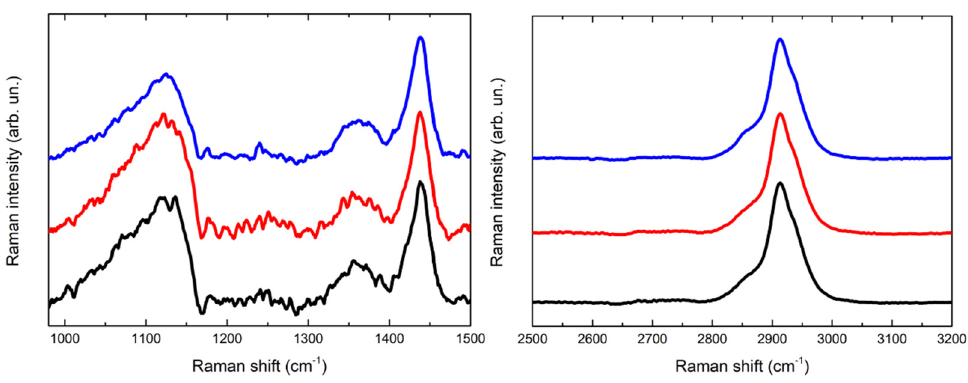
Figure 5. Comparison of three Raman spectra acquired for the reference of PVA-borax hydrogel. Table 1. Tentative assignations of observed Raman peaks for PVA-borax hydrogel.